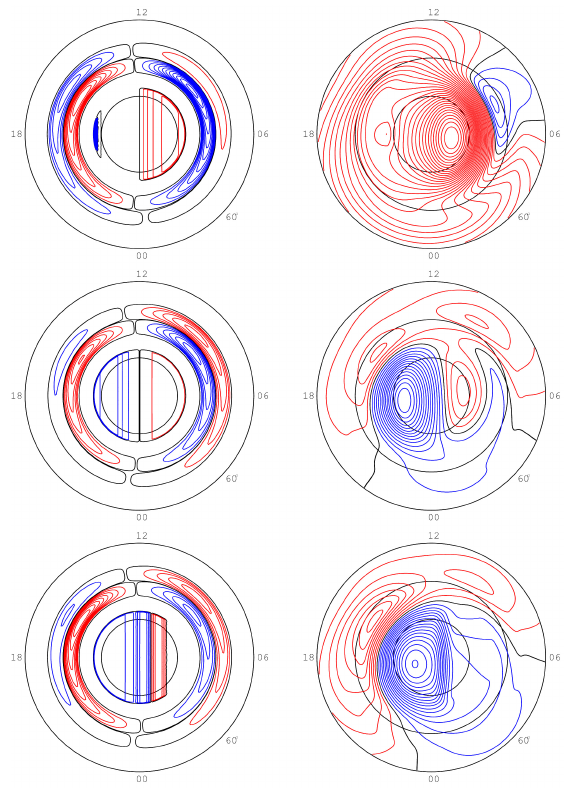
Fig. 10. Shown on the left, modelled field-aligned current patterns (0.1 µ A/m 2 contour separation) for each of the DMSP passes on 8 November 1998; and on the right, the electrostatic potential patterns (3kV contour separation) generated by the KTH model. Upward and downward FACs are shown in red and blue, respectively; posi- tive potentials are shown in blue and negative in red. The black line denotes zero potential. See text for more details.